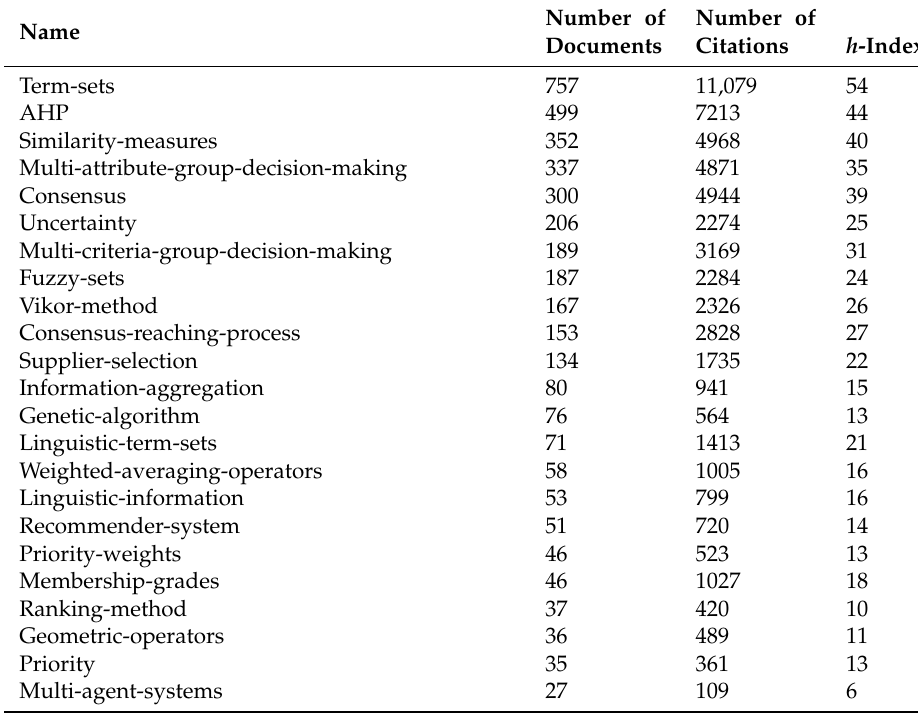
Table 6. Performance of the themes in the 2015–2019 period.